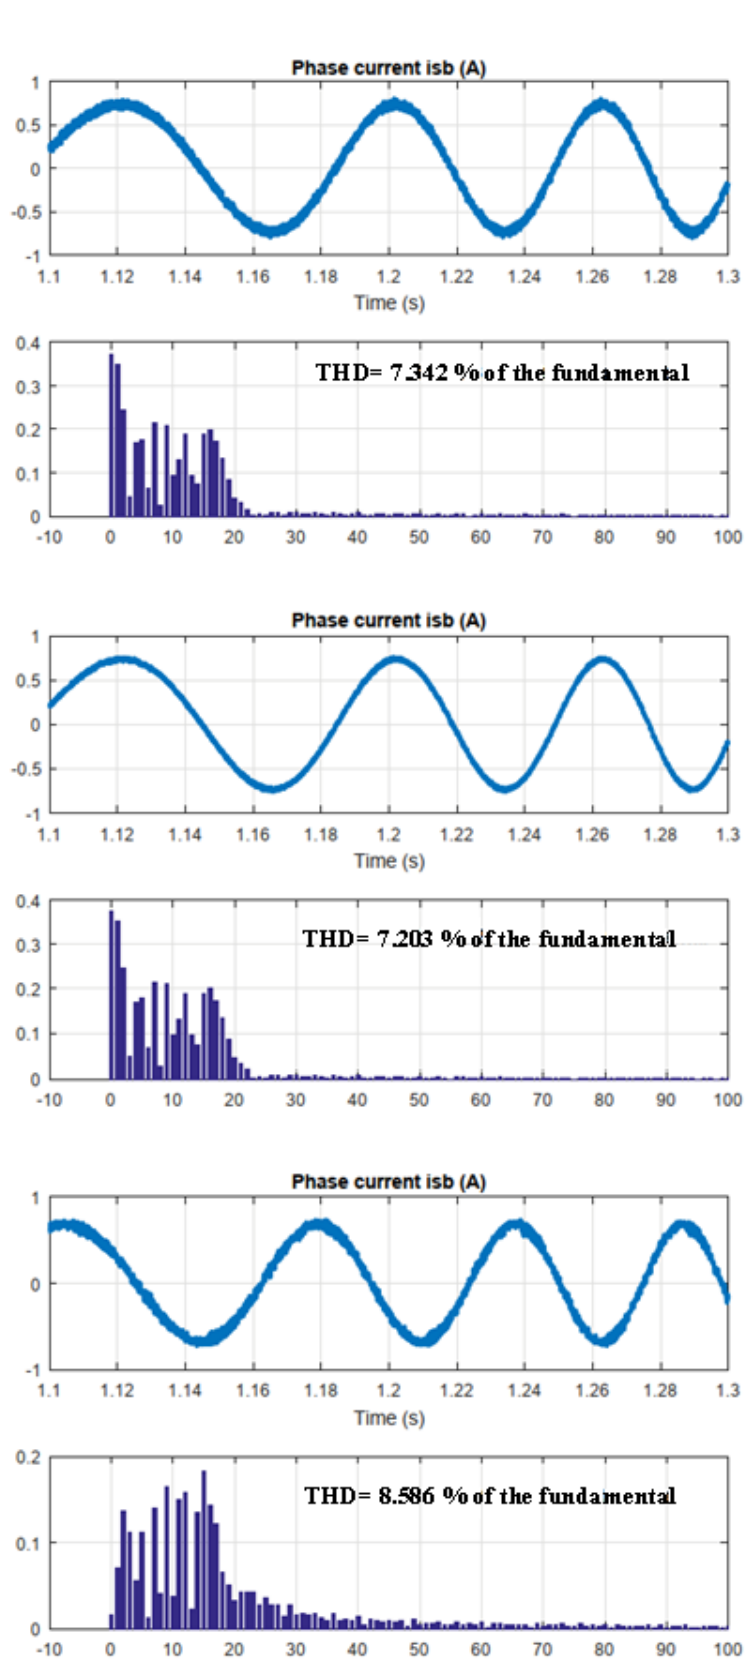
Figure 12. Spectrum analysis of the stator phase current b for the three proposed control 493 techniques.